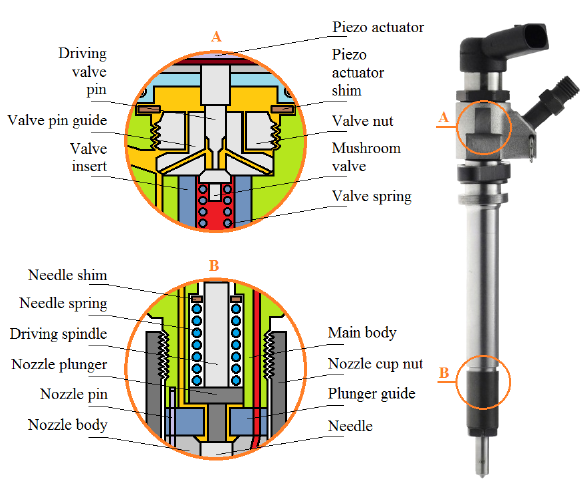
Fig. 1. Siemens VDO Continental PCR 2.3 fuel injector